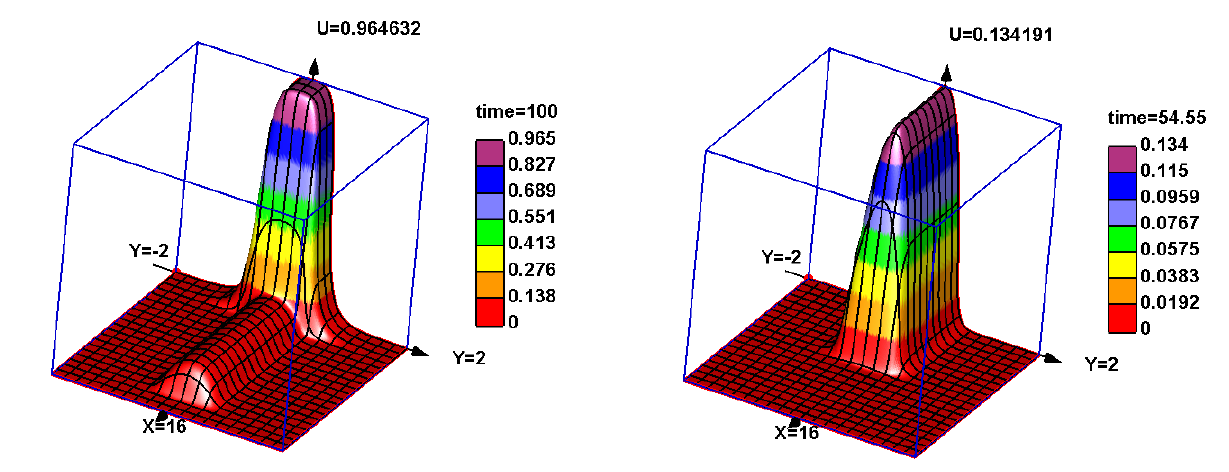
Figure 4. Snapshots of solutions of Equation (1) with two different initial conditions and the same values of parameters. Two waves with different speeds propagate one after another for a sufficiently large initial condition ( left ). A faster monostable wave with a small amplitude is followed by a slower bistable wave with a large amplitude. If the initial condition is small enough, then only the fast monostable wave with a small amplitude is observed ( right ). The values of parameters: D x = D y = 0.005, b = 1, k = 1, y 0 = 0.5, f ( u ) = ( a 1 u + a 2 ) e − a 3 u , a 1 = 15, a 2 = 0, a 3 =